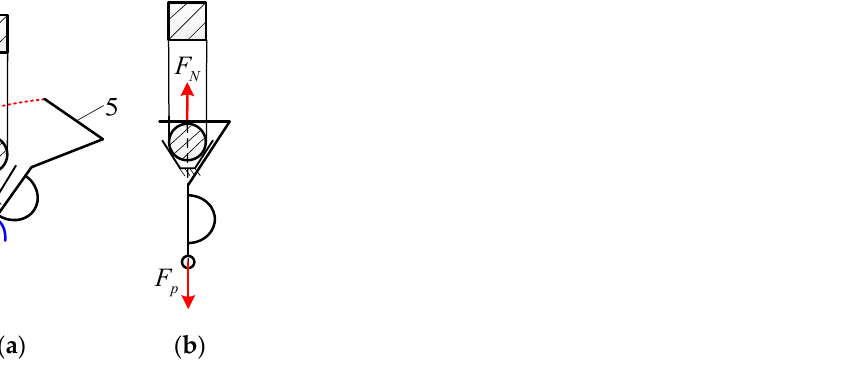
( c ) Figure 16. Schematic diagram of model parameters and trajectory formation process. ( a ) Initial state; ( b ) end state of curve segment trajectory; ( c ) locked state.